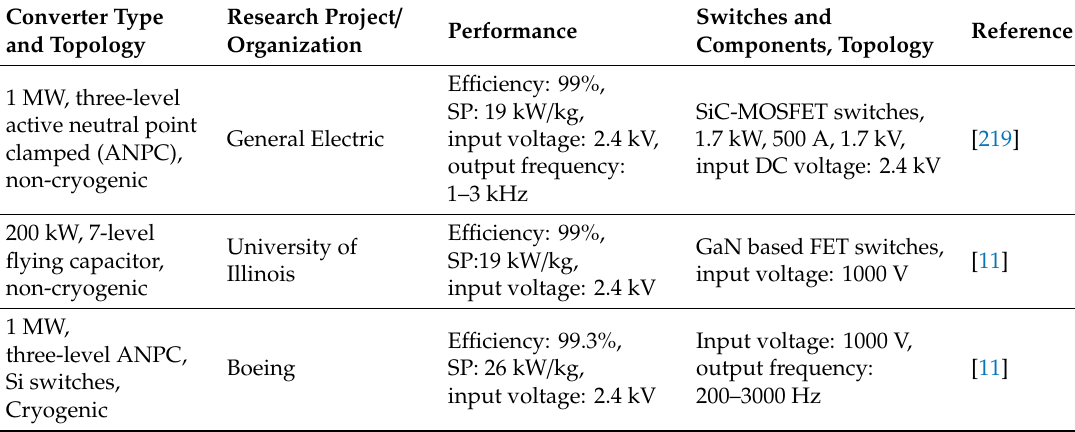
Table 6. Projections in power